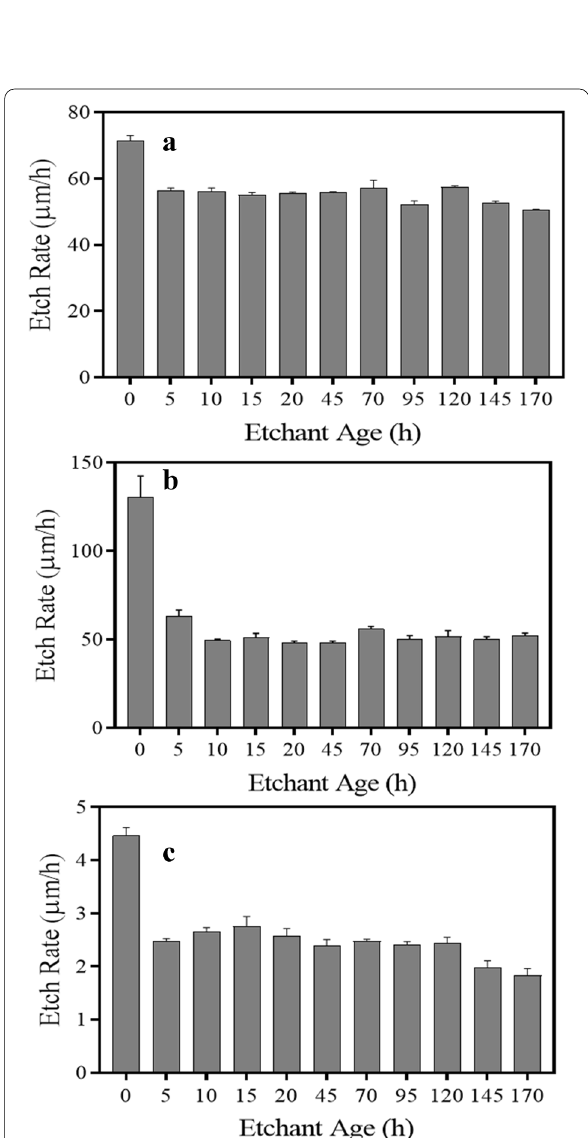
Fig. 30 Effect of aging of 10% NH 2 OH rates of (a) Si{100}, (b) Si{110}, and (c) Si{111} at 70